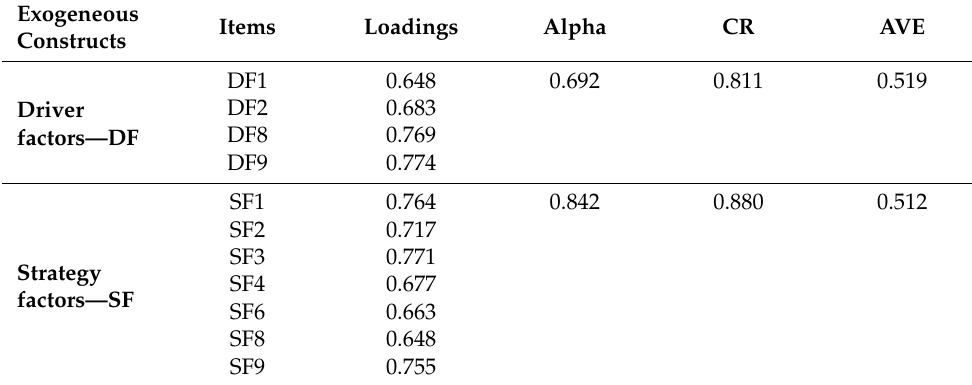
Table 4. Results of measurement model—convergent validity iteration